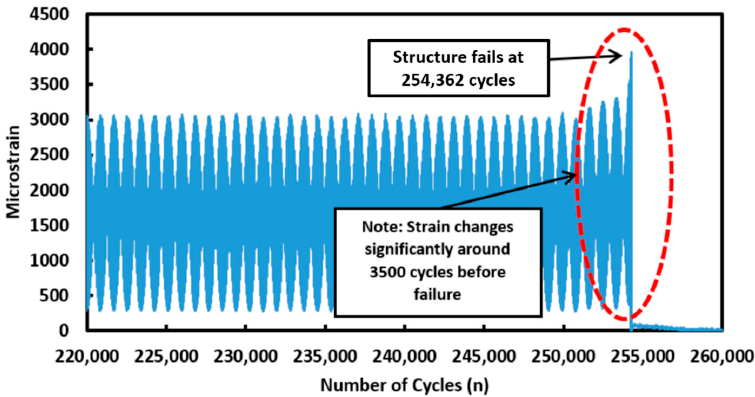
Figure 8. Strain measurement at the centre point along Fibre 1 100,000 cycles before failure occurs.